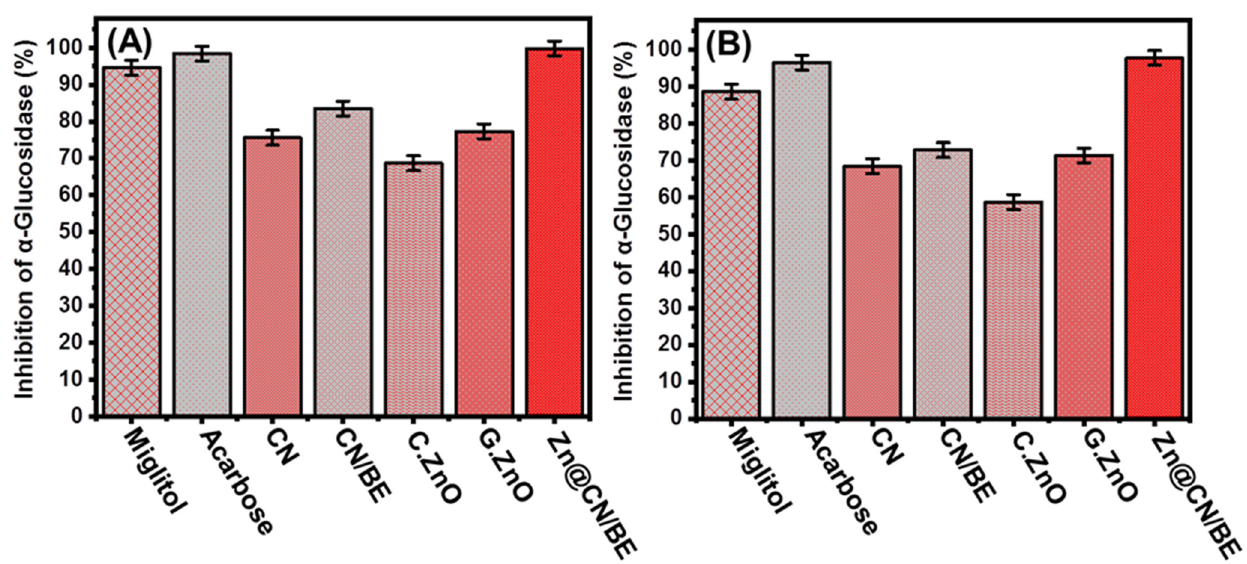
Figure 6. The α -Glucosidase inhibition activities of CN, CN/BE, commercial ZnO, green ZnO, and Zn@CN/BE structures (200 µ L; 100 µ g/mL) (the tests were replicated 5 times); ( A ) Pancreatic α -Glucosidase enzyme (100 μ L; 0.1 unit/mL); and ( B ) Murine intestinal α -Glucosidase enzyme (100 μ L; 0.1 unit/mL).